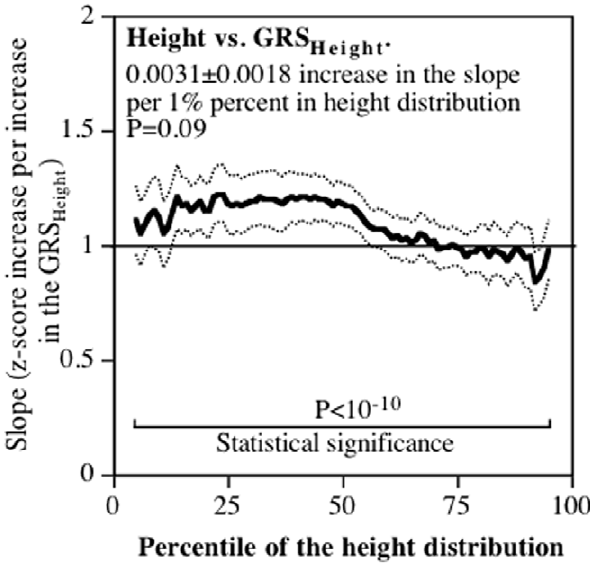
Figure 5. Slopes for height versus GRS Height (Y-axis) by the percentile of the height distribution (X-axis). Lighter lines designate 6 one standard error.